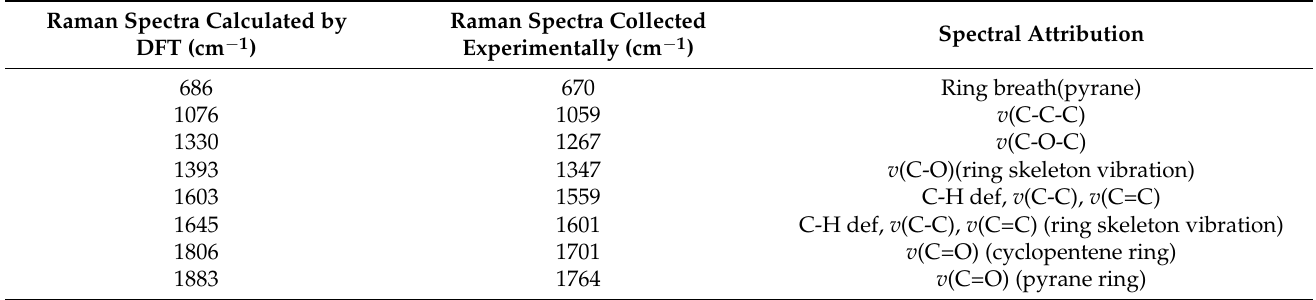
Table 2. Raman characteristic peak attribution.